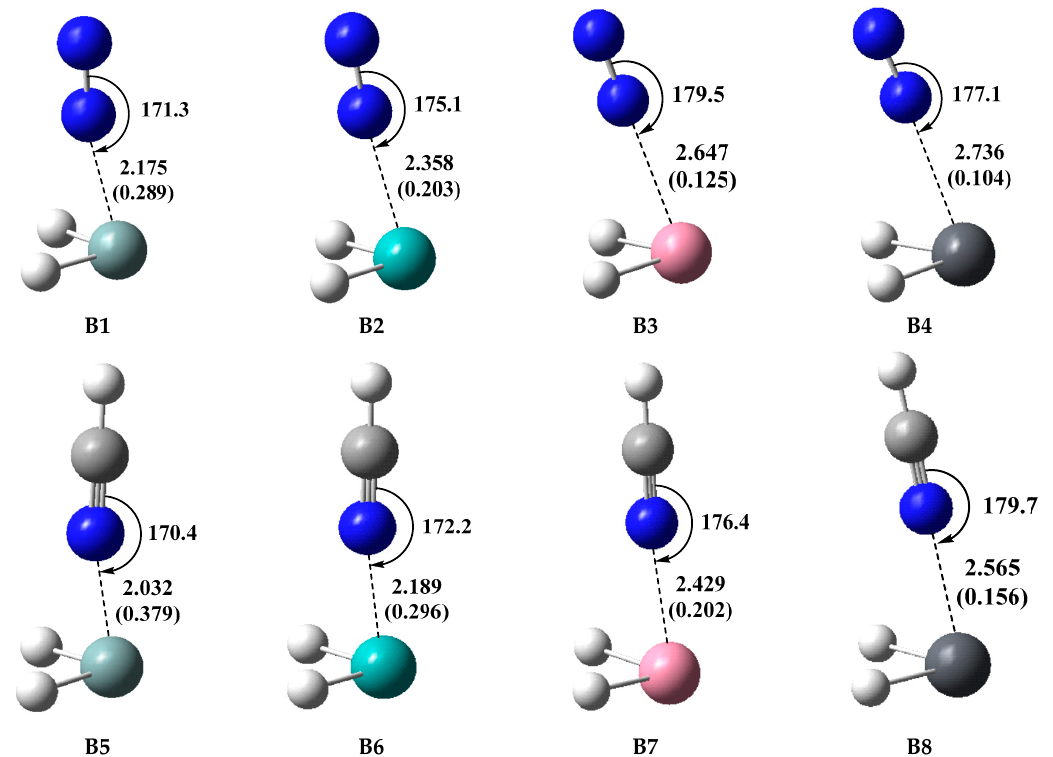
Figure 8. Optimized geometries of the type-B complexes involving N 2 and HCN at the MP2/aug-cc-pVDZ level, distances in Å, angles in °, and WBI values (in parenthesis).